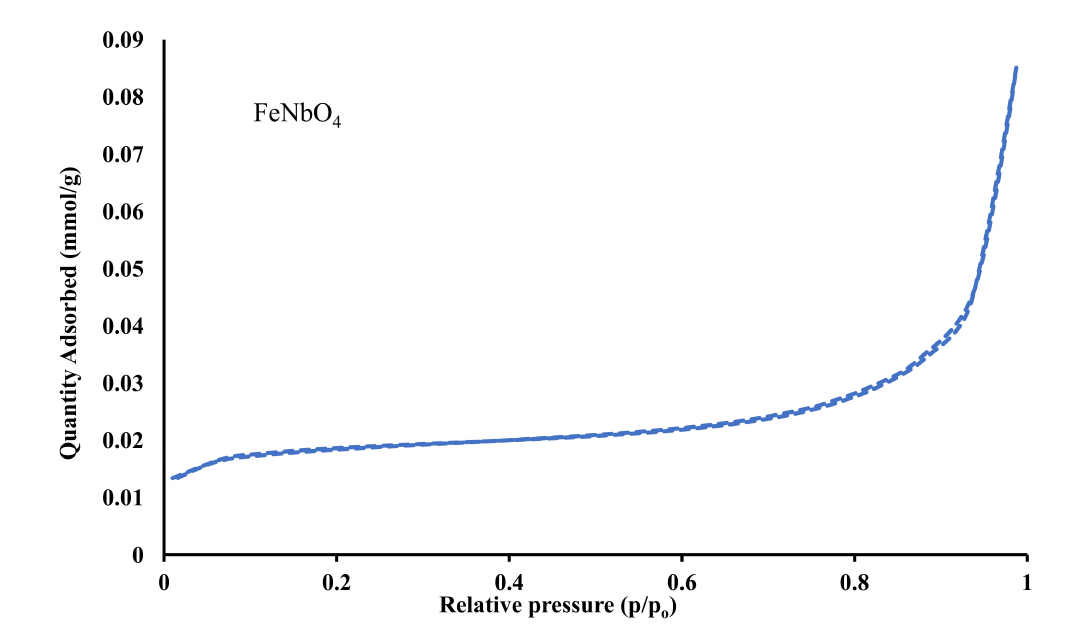
Figure 4. N 2 adsorption-desorption isotherm of pure FeNbO 4 .